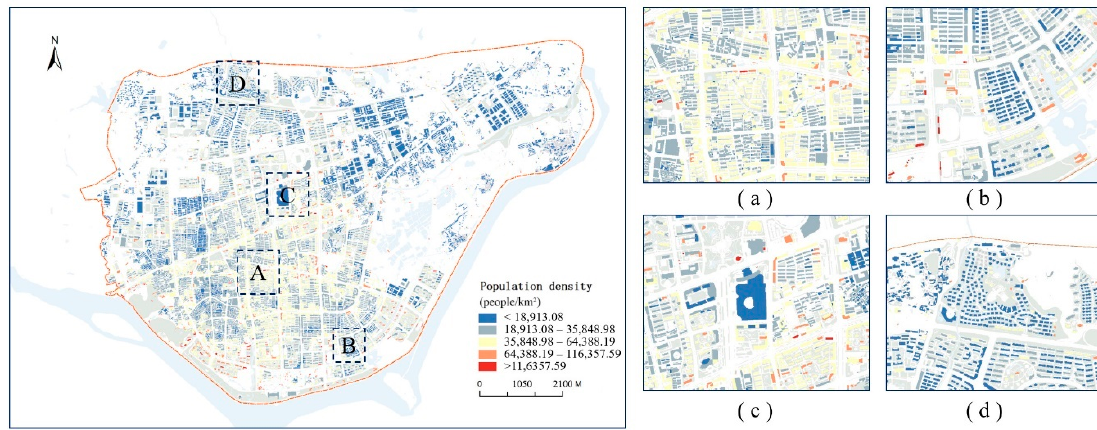
Figure 4. Map of population distribution at the building scale. Map of population distribution at the building scale: ( a ) population distribution in block A; ( b ) population distribution in block B; ( c ) population distribution in block C; ( d ) population distribution in block D.